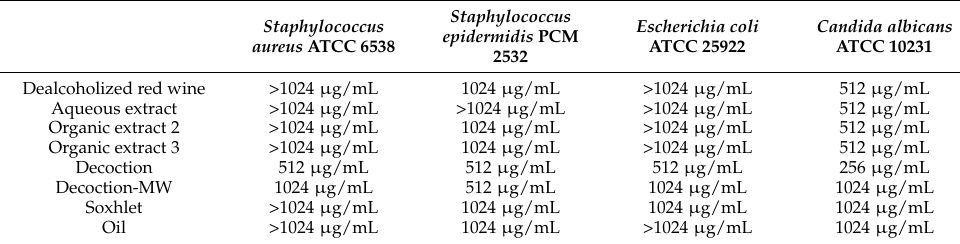
Table 7. Results of antimicrobial assay-minimum inhibitory concentration